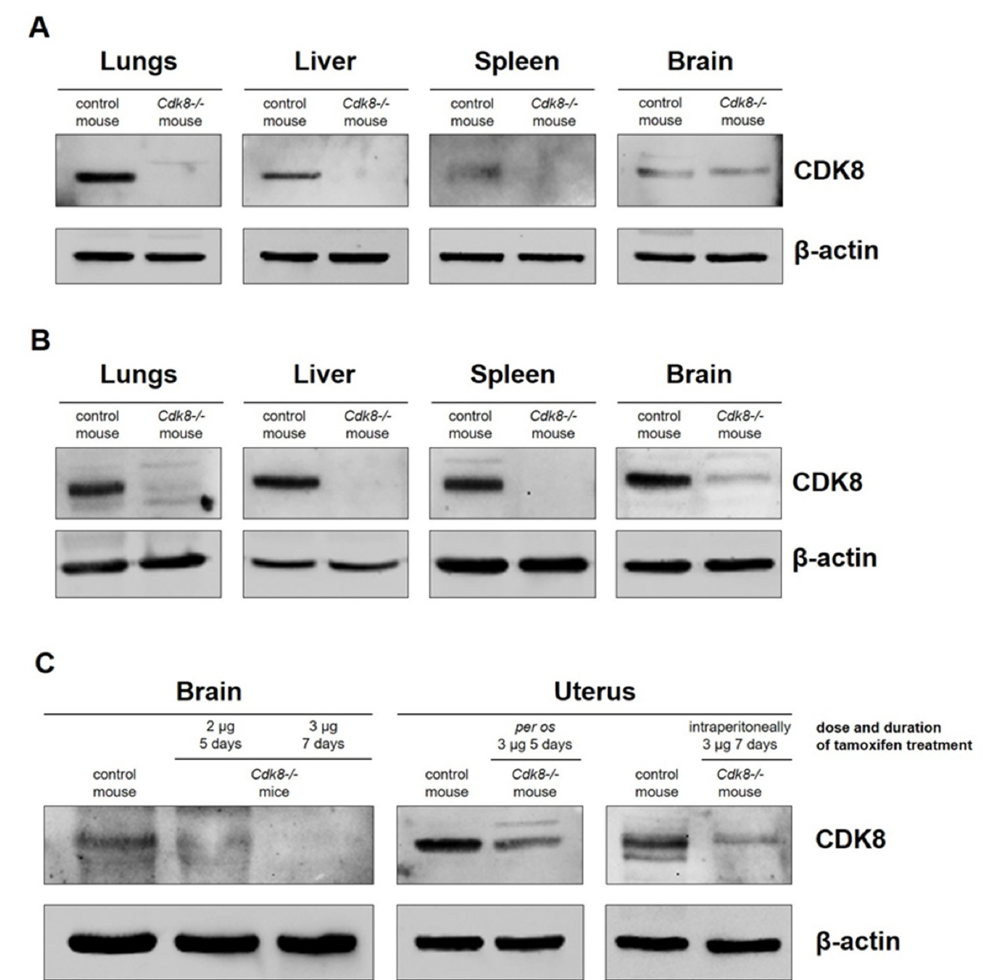
Figure 1. Detection of the tamoxifen-induced Cdk8 knockout in different organs of mice: ( A ) feeding method of tamoxifen administration; ( B ) injection method of tamoxifen administration. ( C ) Detection of the tamoxifen-induced Cdk8 knockout in the mouse brain and uterus (original oral and improved injection methods of tamoxifen administration).